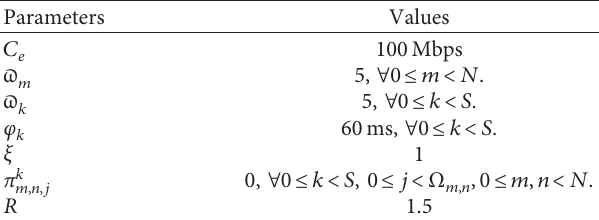
Table 3: Initial network configuration parameters. Parameters